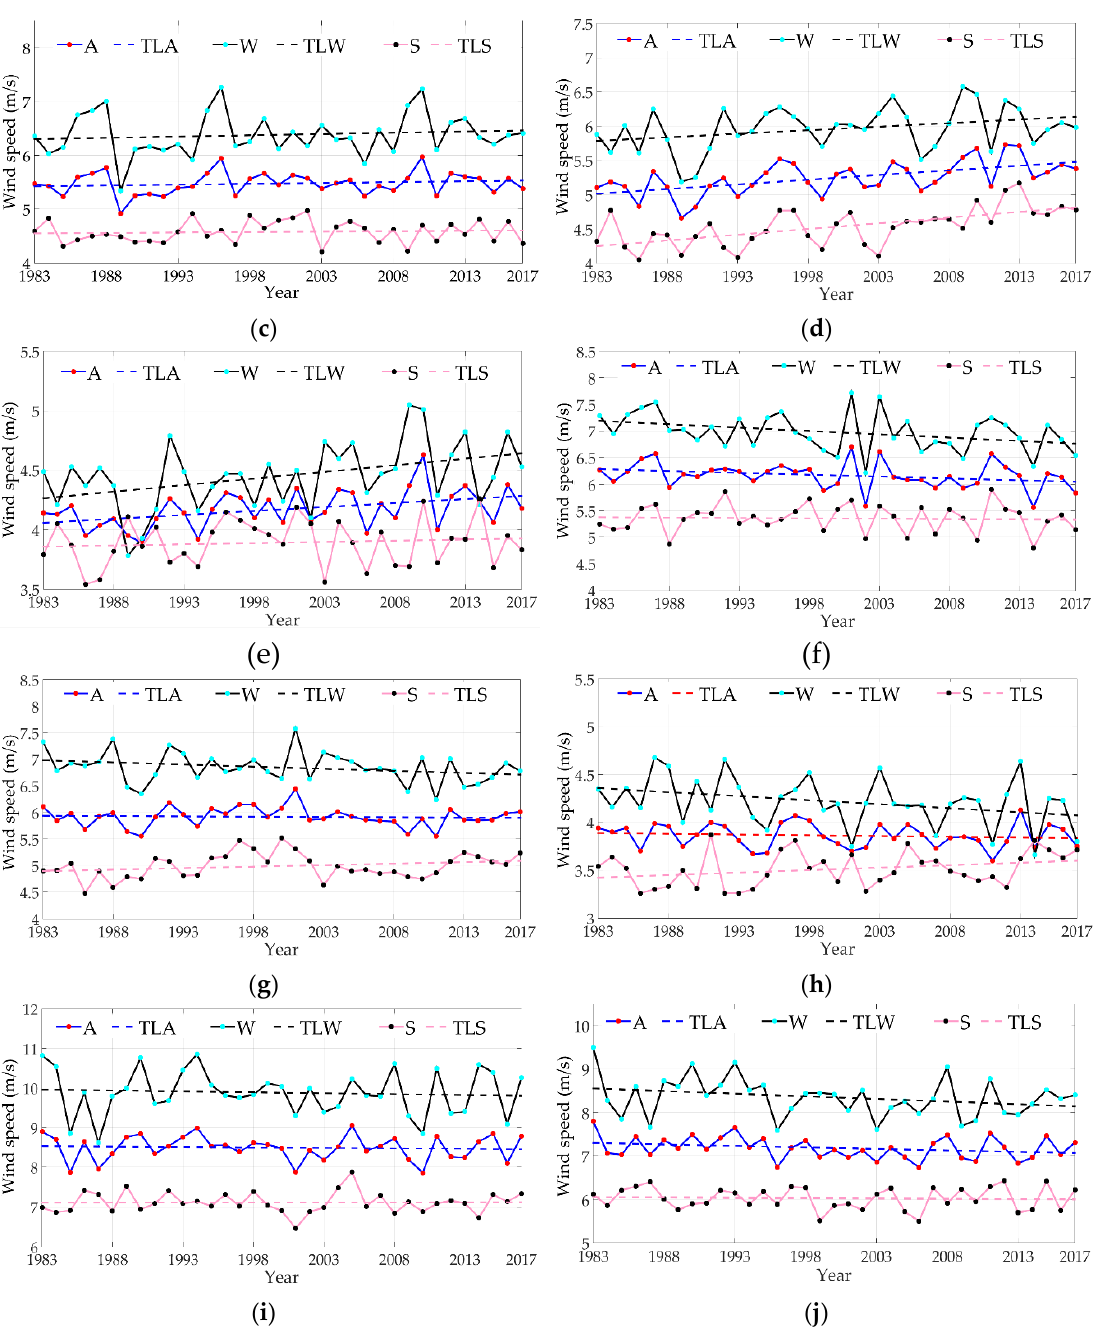
Figure 5. Representation of the wind speed (U10) for the annual averages (A), winter (W) and summer (S) seasons corresponding to the most representative points; ( a ) A3, Balearic Sea; (also) B1, Ligurian Sea; ( c ) C4, Tyrrhenian Sea; ( d ) D3, Adriatic Sea; ( e ) E3, Ionian Sea; ( f ) F1, Aegean Sea; ( g ) G1, Black Sea; ( h ) H2, Levantine Sea; ( i ) I1, North Sea; and ( j ) J2, Baltic Sea. TLA represents the trend line for the annual averages, while TLW and TLS are the trend lines for the winter and summer seasons, respectively. Results corresponding to the35-year time interval 1983 – 2017.